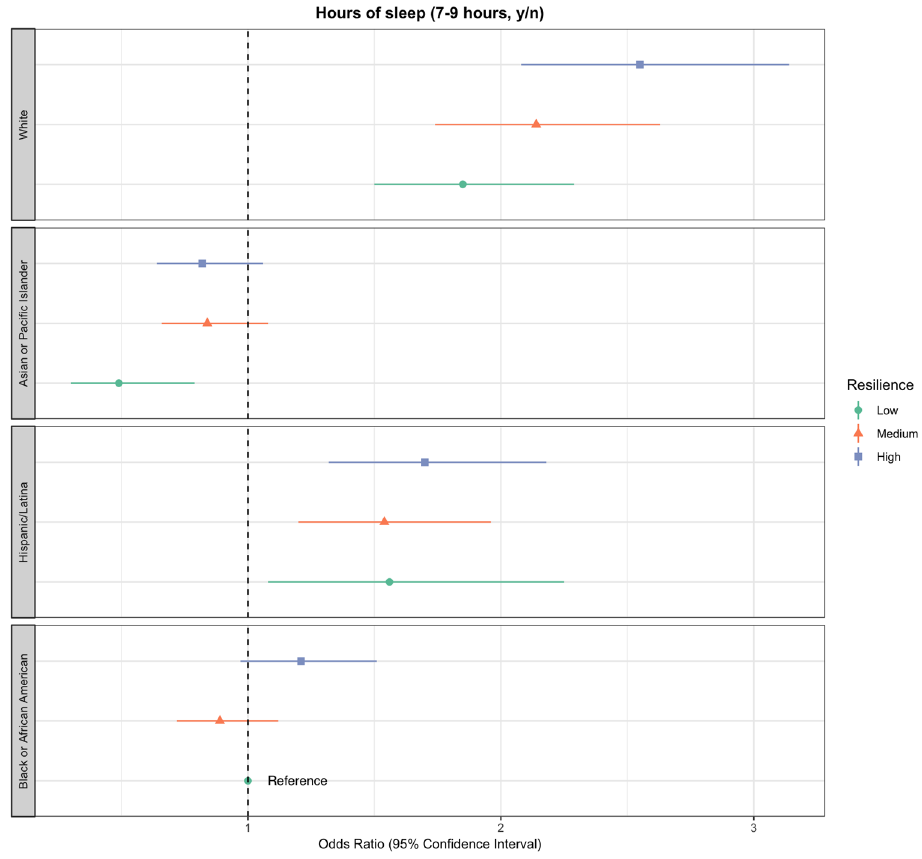
Figure 2. Estimated associations between self-reported psychological resilience and adequate sleep (recommended 7–9 h per night), adjusted for stressful life events (SLEs), sociodemographic information (age, race/ethnicity, and education), additional CVD-protective risk factors (BMI, diabetes, hypertension, and high cholesterol), and interaction between race/ethnicity and resilience. The odds ratio for each category is displayed along with bars representing 95% confidence intervals.